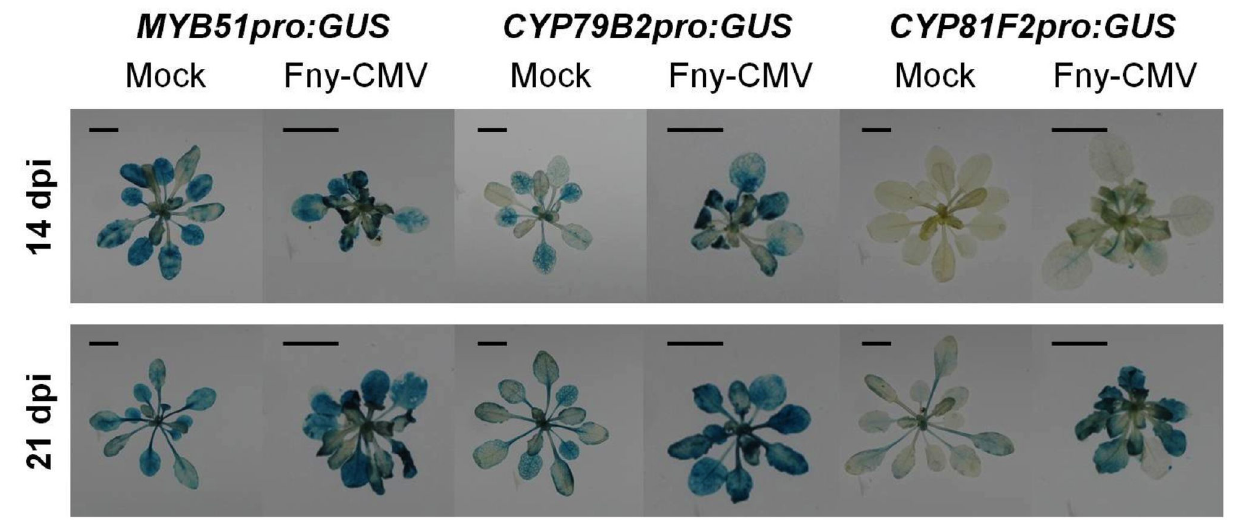
Figure 4. Induction of GUS reporter genes fused to the promoters of MYB51 , CYP79B2 , and CYP81F2 in response to Fny- CMV infection at 14 and 21 days post-inoculation (dpi). Three plants per treatment group, per time-point were analyzed and photographs were taken of representative plants. Scale bars represent 1 cm.